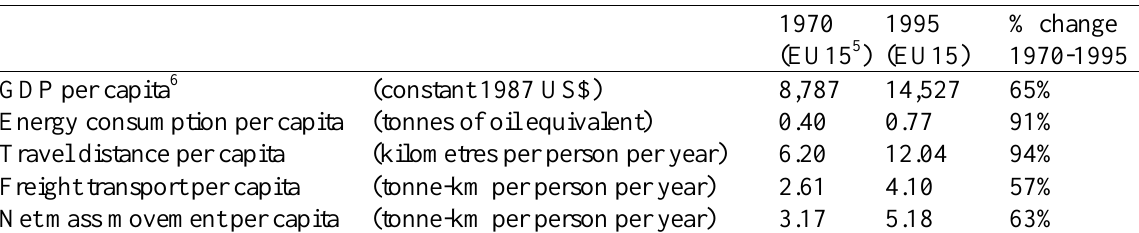
Table 1. Transport and Economic Trends in Europe,